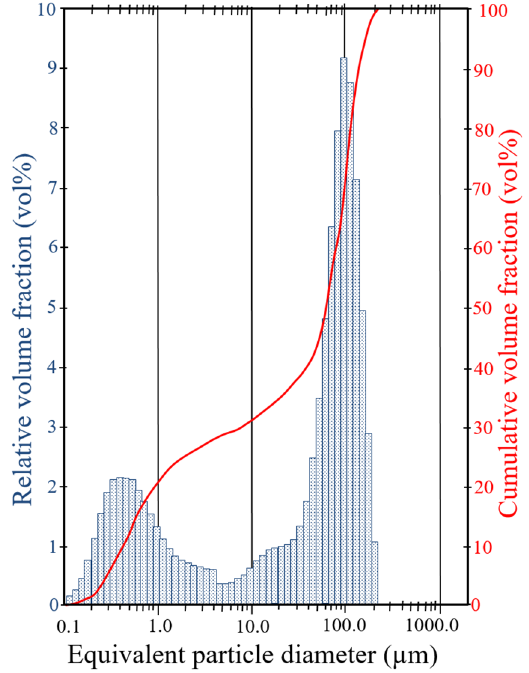
Figure 6. Particle size distribution in vol% of the calcined Sra Ouertane (layer A1) phosphate rock.